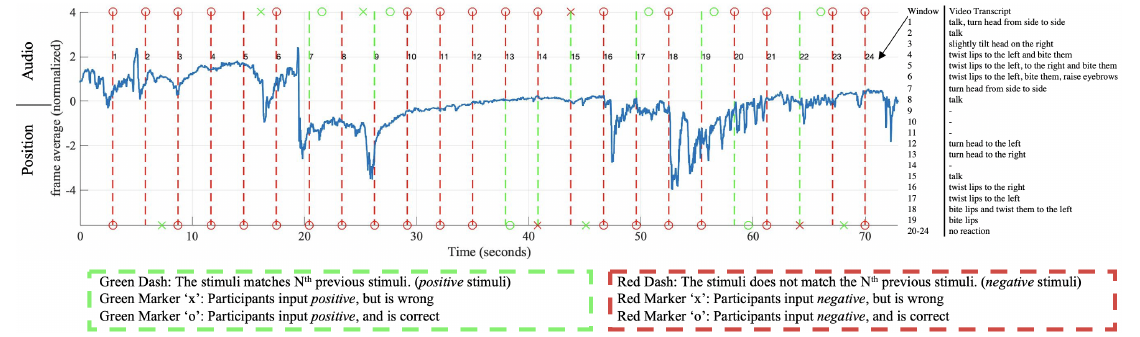
Figure 11. Signal examples of the double 2-back test from two participants. The signal plotted in blue is per frame average. The dash lines indicate the appearances of stimulus, with audio stimulus above and position stimulus below the zero line. The markers are user inputs as explained in the figure. A window is defined between every two stimulus (dash lines). The manual video transcript of every window is shown next to the